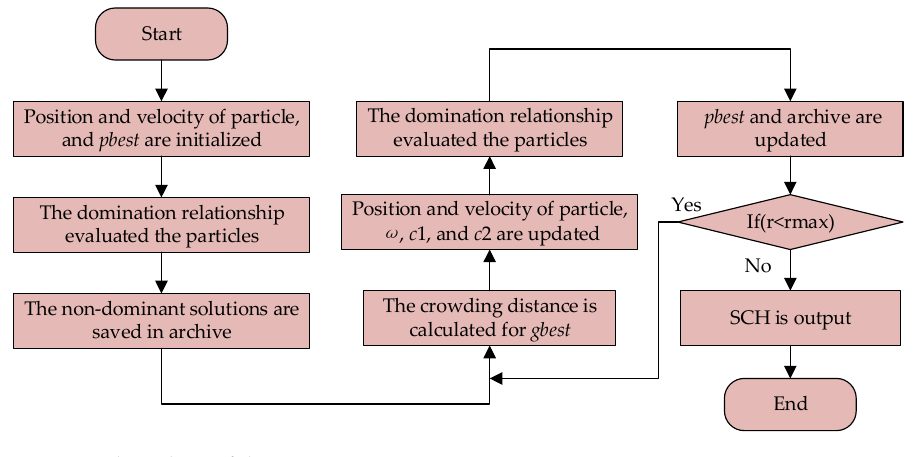
Figure 7. Flow chart of the MOPSO.